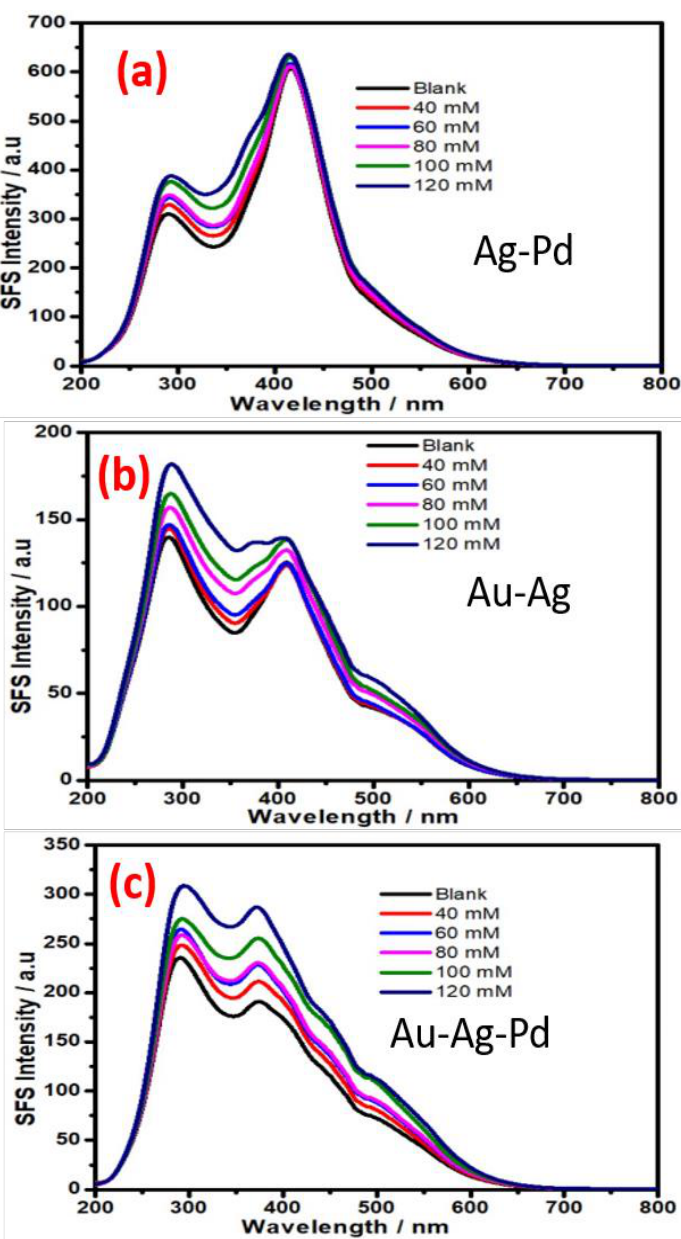
Figure 8. Synchronous fluorescence spectra at δλ = 0 nm recorded at various concentration of glucose: ( a ) bimetallic (Ag-Pd) NPs, ( b ) bimetallic (Ag-Au) NPs, and ( c ) trimetallic (Au-Ag-Ap) NPs.